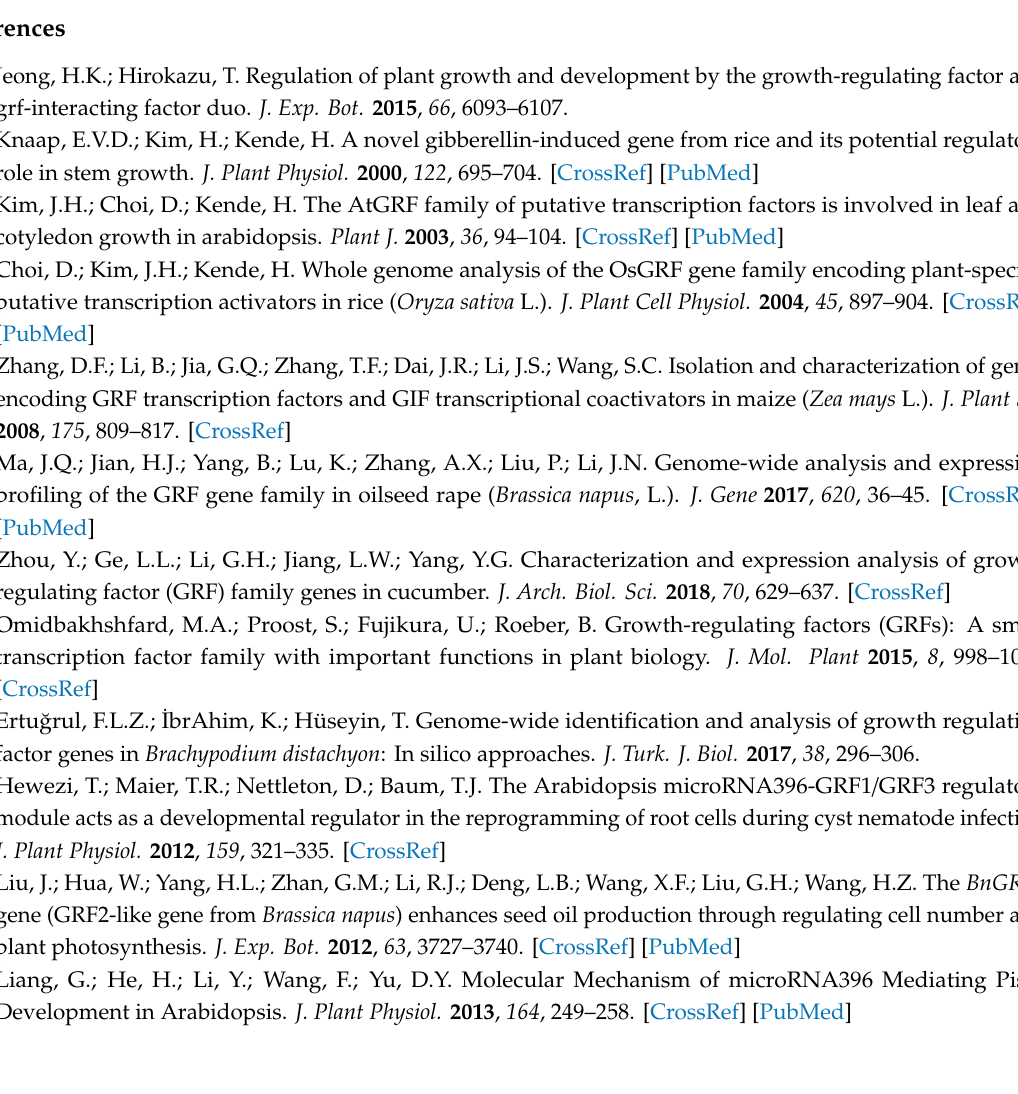
Figure S1. Distribution of AhGRF genes in the cultivated peanut genome. The chromosomal position of each AhGRF genes was mapped to the cultivated peanut genome. The chromosome number is indicated above each chromosome. Figure S2. Sequence alignment of WRC and QLQ motifs in AhGRF genes. Figure S3. Morphological changes in three peanut materials during seed development. A.mon (Arachis monticola tetraploid wild species), H8106 and 8107 lines indicate the two peanut recombinant inbred lines (RILs). 15~DAF, 25~DAF, 35~DAF, 45~DAF, and 60~DAF indicate about 15, 25, 35, 45, and 60 days after flowering, respectively. Table S1. Summary of the peanut AhGRF gene family. Table S2. Putative motifs conserved in the amino acid sequences of peanut AhGRF proteins. Table S3. Amino acid sequences of 68 GRF proteins from 4 plant species. Table S4. Expression levels of AhGRF genes in three peanut varieties. Table S5. Summary of the AhGRF genes family in Arachis duranensis and Arachis ipaensis. Table S6. Primers used for qRT-PCR analysis. Table S7. The sequences of AhGRF5a and AhGRF5b. Table S8. The original Real-time quantitative PCR data of AhGRF5 a and AhGRF5